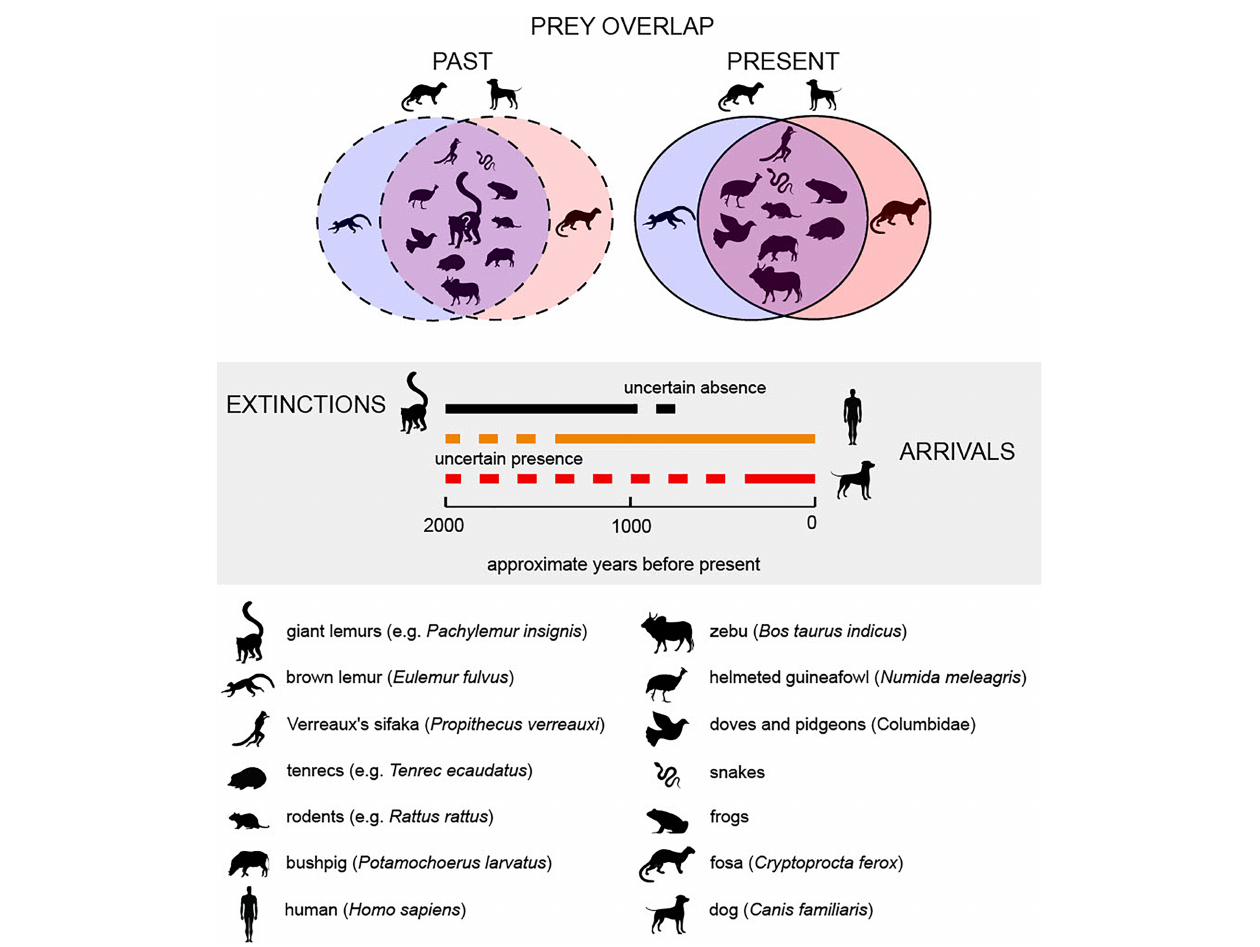
FIGURE 2 | Overlaps in dog and C. ferox diet (top) and chronology of extinctions and arrivals as understood before the present study (center, shaded, with uncertain occurrence prior to this publication marked with dashed lines). The spread of dogs (red bar) to Madagascar before European contact ( ∼ 500 BP) has been poorly documented, and it is unknown whether they overlapped chronologically with extinct megafauna such as giant lemurs (black bar). Dogs and C. ferox currently scavenge and prey on many of the same animals (see inexhaustive list at bottom), but the antiquity of this dietary overlap is unknown (dashed lines). Before the present study, it was unknown whether past dogs preyed on extinct giant lemurs, yet there are abundant traces of human and mammalian carnivoran predation on extinct giant lemurs. Note that examples of exclusively dog or C. ferox prey are token and do not represent the diversity of predator-specific diets (see Supplementary Datasets 2, 3